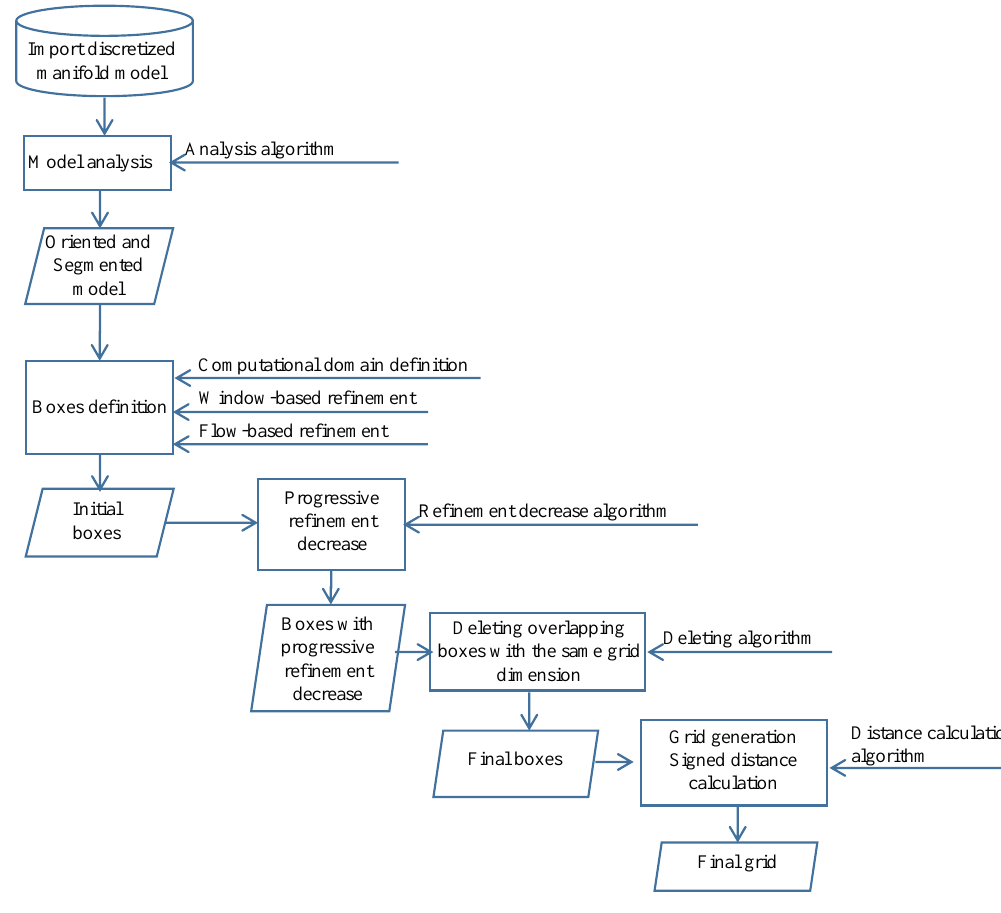
Figure 1. Flow-chart of the proposed